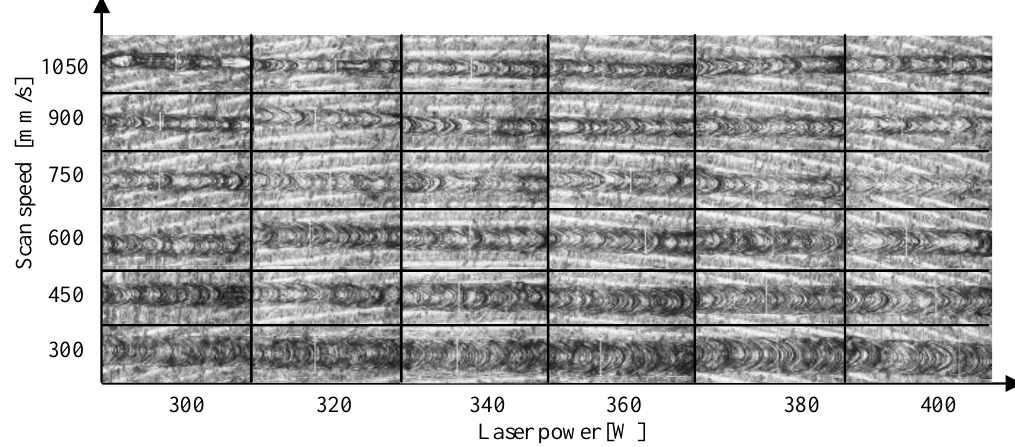
Figure 8. Optical images of the surface morphologies of the single track samples with laser power ranging from 300 – 400 W and scan speed ranging from 300 – 1050 mm/s.